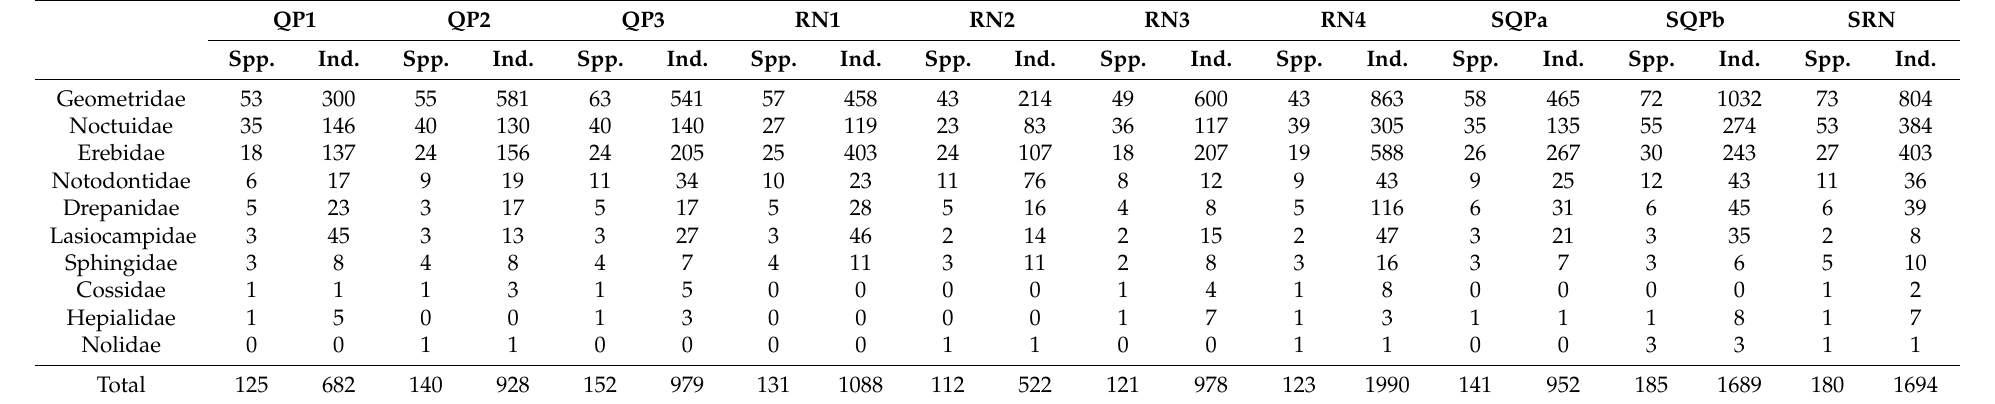
Table 3. Number of species and individuals from the families recorded in each study site in the NNP, Podlaskie, North-East Poland. QP1 QP2 QP3 RN1 RN2 RN3 SRN Spp. Ind. Spp. Ind. Spp.